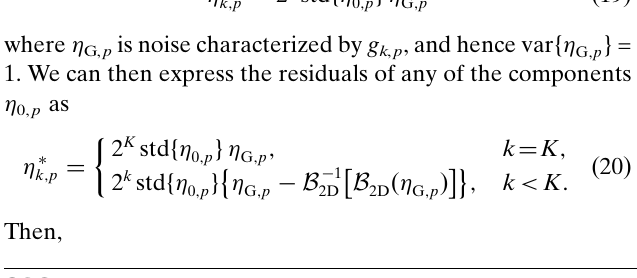
is a two-dimensional white random field. The field where (cid:2) G,2D | is included only for the normalization of the Fourier size | X G transform, and the formula holds for an arbitrary size.